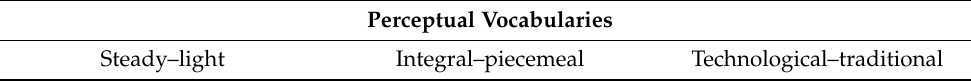
Table 1. The selected perceptual vocabularies of truck cranes.